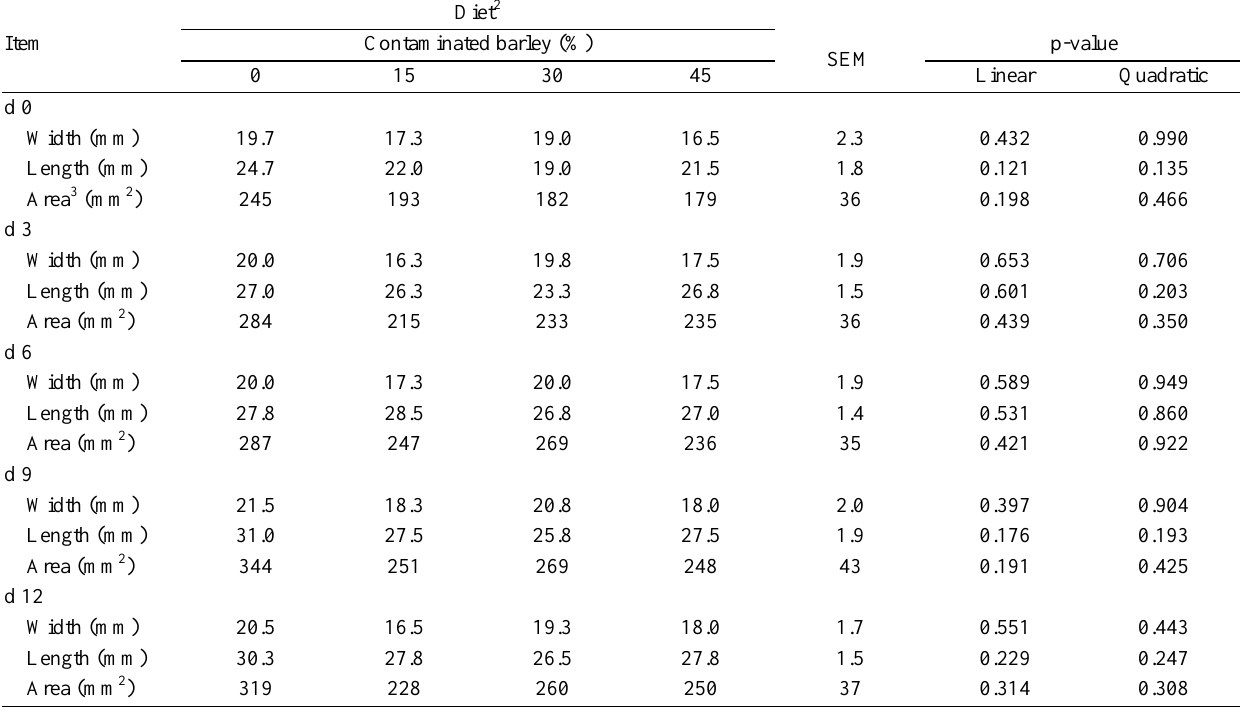
Table 5. Vulva size of pigs fed experimental diets containing increasing amounts of barley naturally contaminated with Fusarium mycotoxins 1 , Exp.